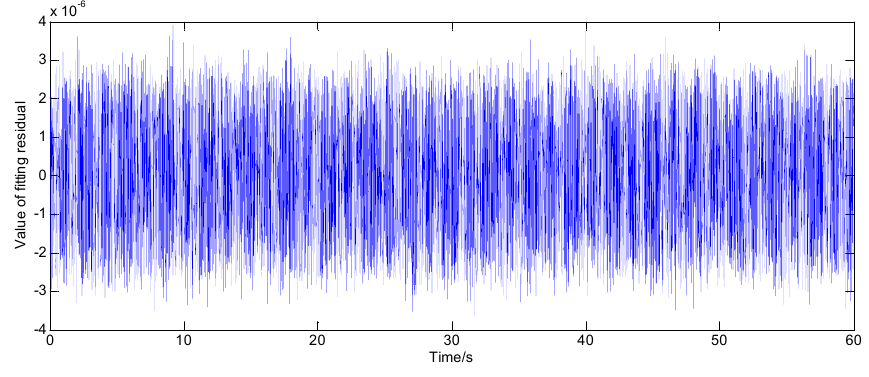
Figure 1. Fitting residual error sequence.